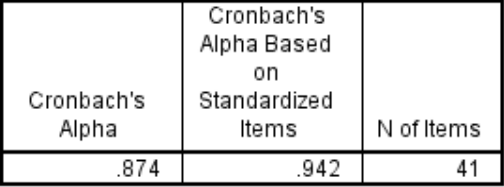
Table 1. Result for cronbach alpha using SPSS software Reliability values between 0.70 and 0.80 are considered to be “respectable” while those between 0.80 and 0.90 are deemed “very good” (Ni Riordain et al.